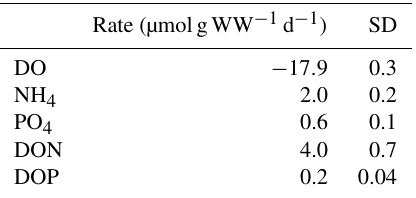
Table 1. Daily oxygen consumption and nutrient release rates stan- dardized to jellyfish ( R. nomadica ) biomass (µmolgWW − 1 d − 1 ) . The average wet weight of the whole jellyfish was 1 . 5 ± 0 . 4kg. N =